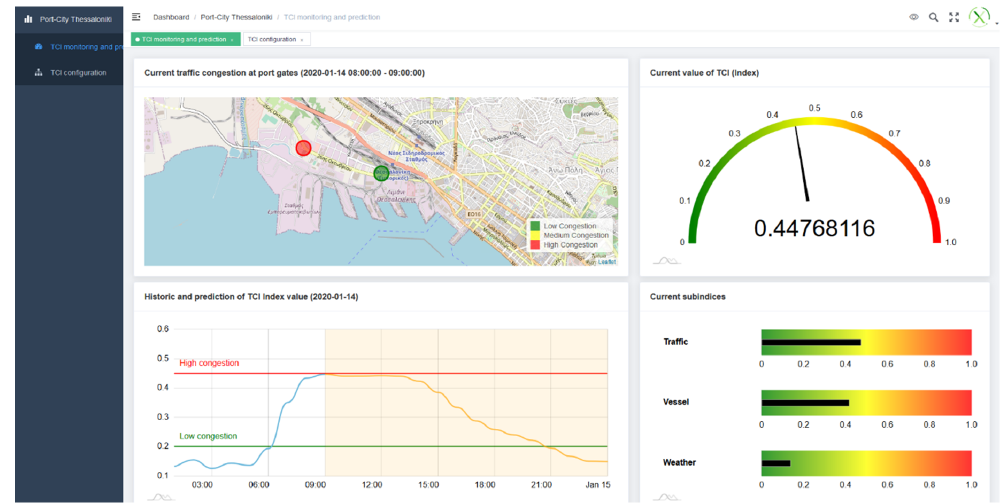
Figure A10. Visualization of the scenario 3.1 in the UI dashboard. Sensors 2020 , 20 , x FOR PEER REVIEW